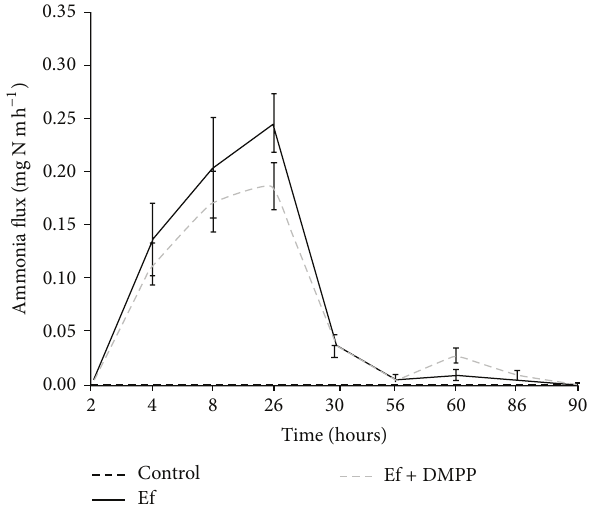
Figure 2: Ammonia volatilization detected by chambers method tube. Manual measurements were done at the beginning of the treatment and for 92 hs after. Control is the soil with any treatment, Ef is bovine manure effluent only, and Ef + DMPP is combination of bovine manure effluent and 3,4 DMPP.